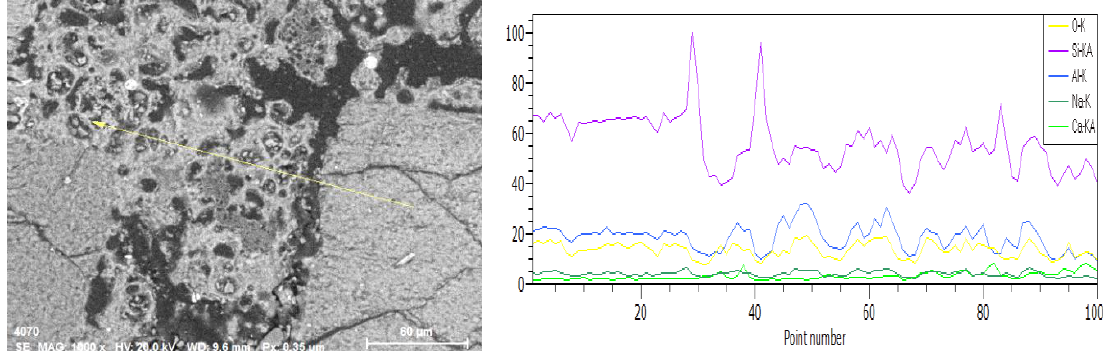
Figure 13. Linear analysis carried out with a scanning microscope using an EDS detector, under variable vacuum conditions, 1000× magnification, EHT 20 kV, WD 9.6 mm, mortar with FA only, annealed at 1000 °C, designated as M0/1000 °C.